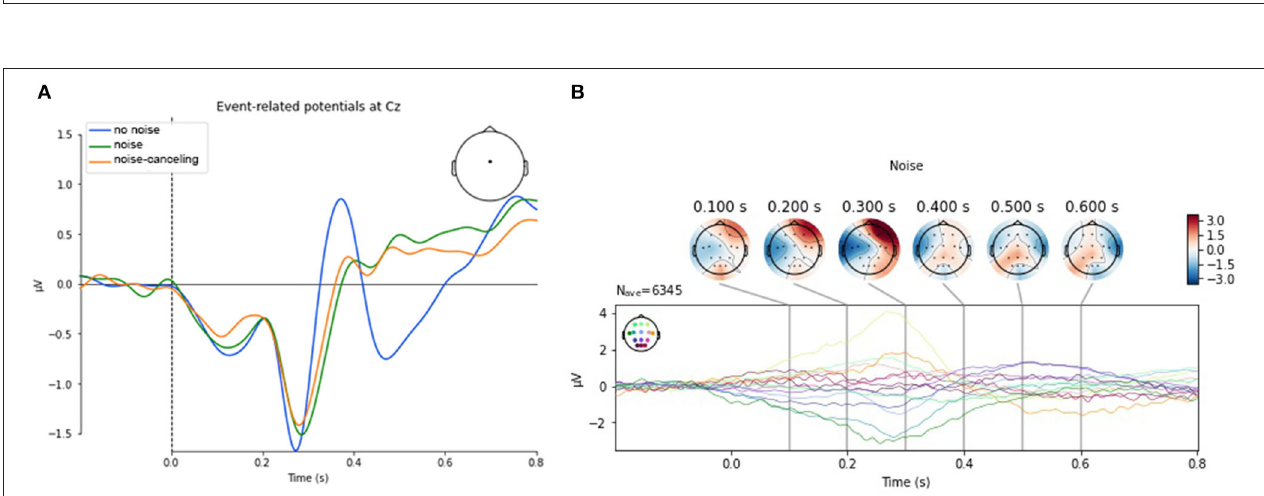
FIGURE 4 | Topographies of the different frequency bands for noise , no noise , and noise-canceling condition. The red colored intensity shows the normalized power spectral density values. The scaling of the intensities was adjusted according to the frequency bands.